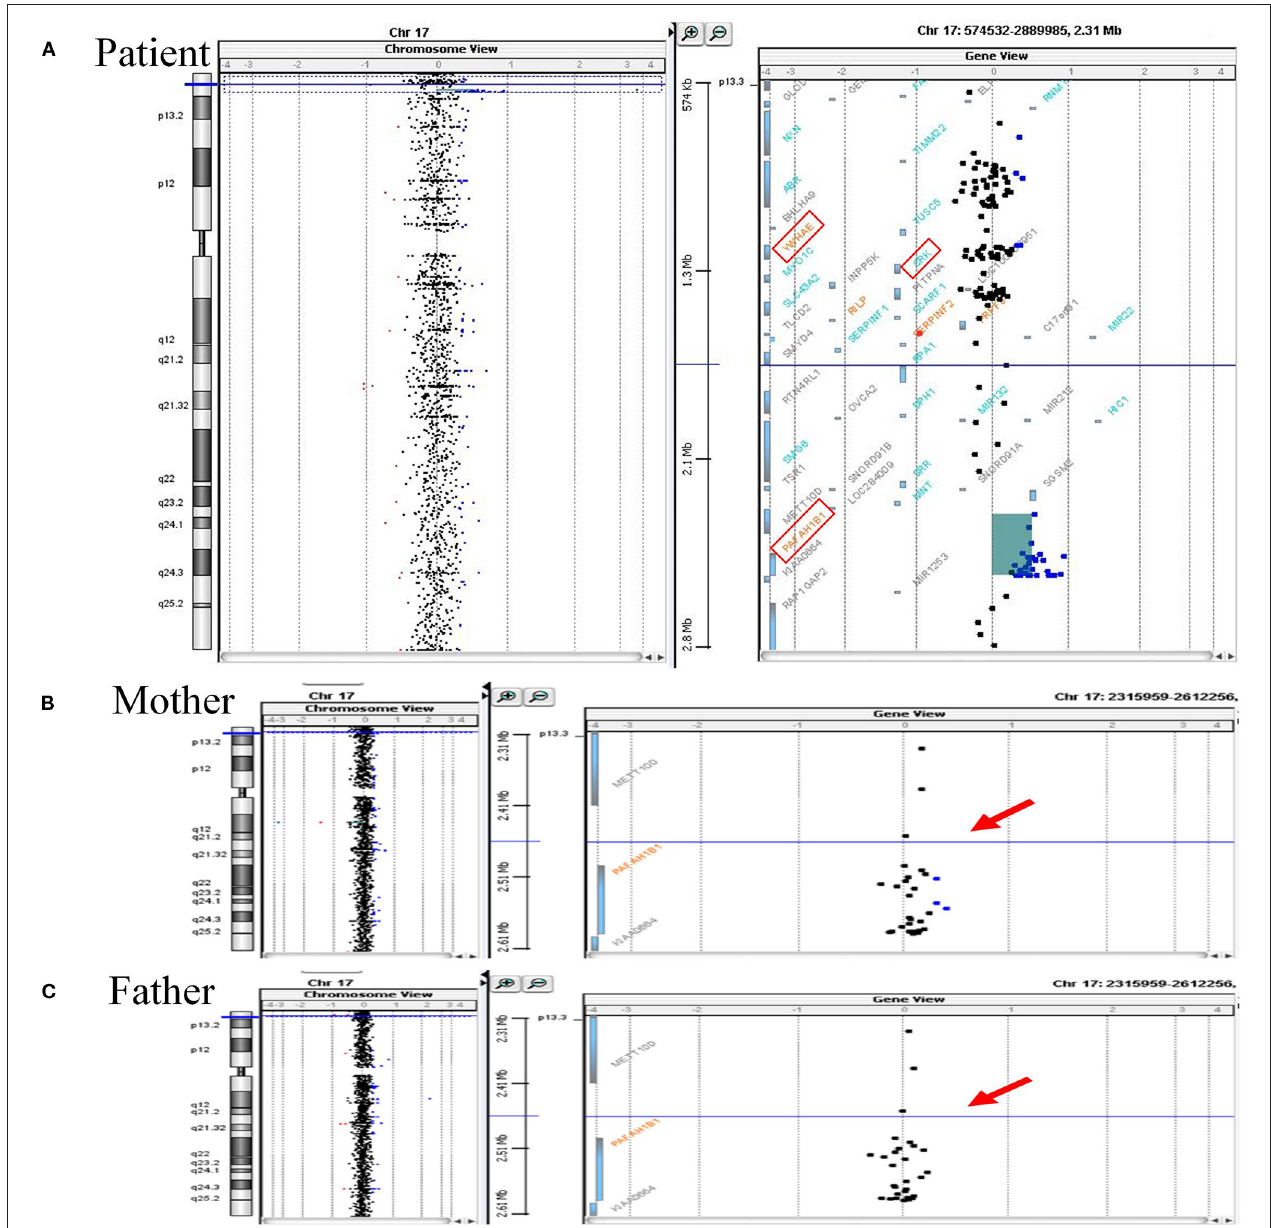
FIGURE 1 | Array CGH analyses of chromosome 17 of the patient and his parents. (A) Array CGH detected a gain of 0.249Mb (approximately log 2 1.5-fold increase) at chromosome 17p13.3 (2,339,561–2,588,655) in the patient. Increased relative fluorescence intensities are shown for a total of 29 labeled DNA probes (represented as the blue-colored dots). The duplicated chromosome region harbors PAFAH1B1 , while another two candidate genes associated with chromosome 17p13.3 microduplication syndrome, namely YWHAE and CRK, have a normal copy number (the three candidate genes are marked by the red square frames). (B,C) The same genomic region (indicated by red arrows) of the patient’s parents were essentially normal. Duplicated circular binary segmentation algorithms, consisting of the genomic position and the log 2 copy number ratio, were plotted using Agilent CytoGenomics Software Version 1.5. Arabic numerals on the horizontal axis denote the log 2 copy number ratio (from log 2 ratios − 4 to +